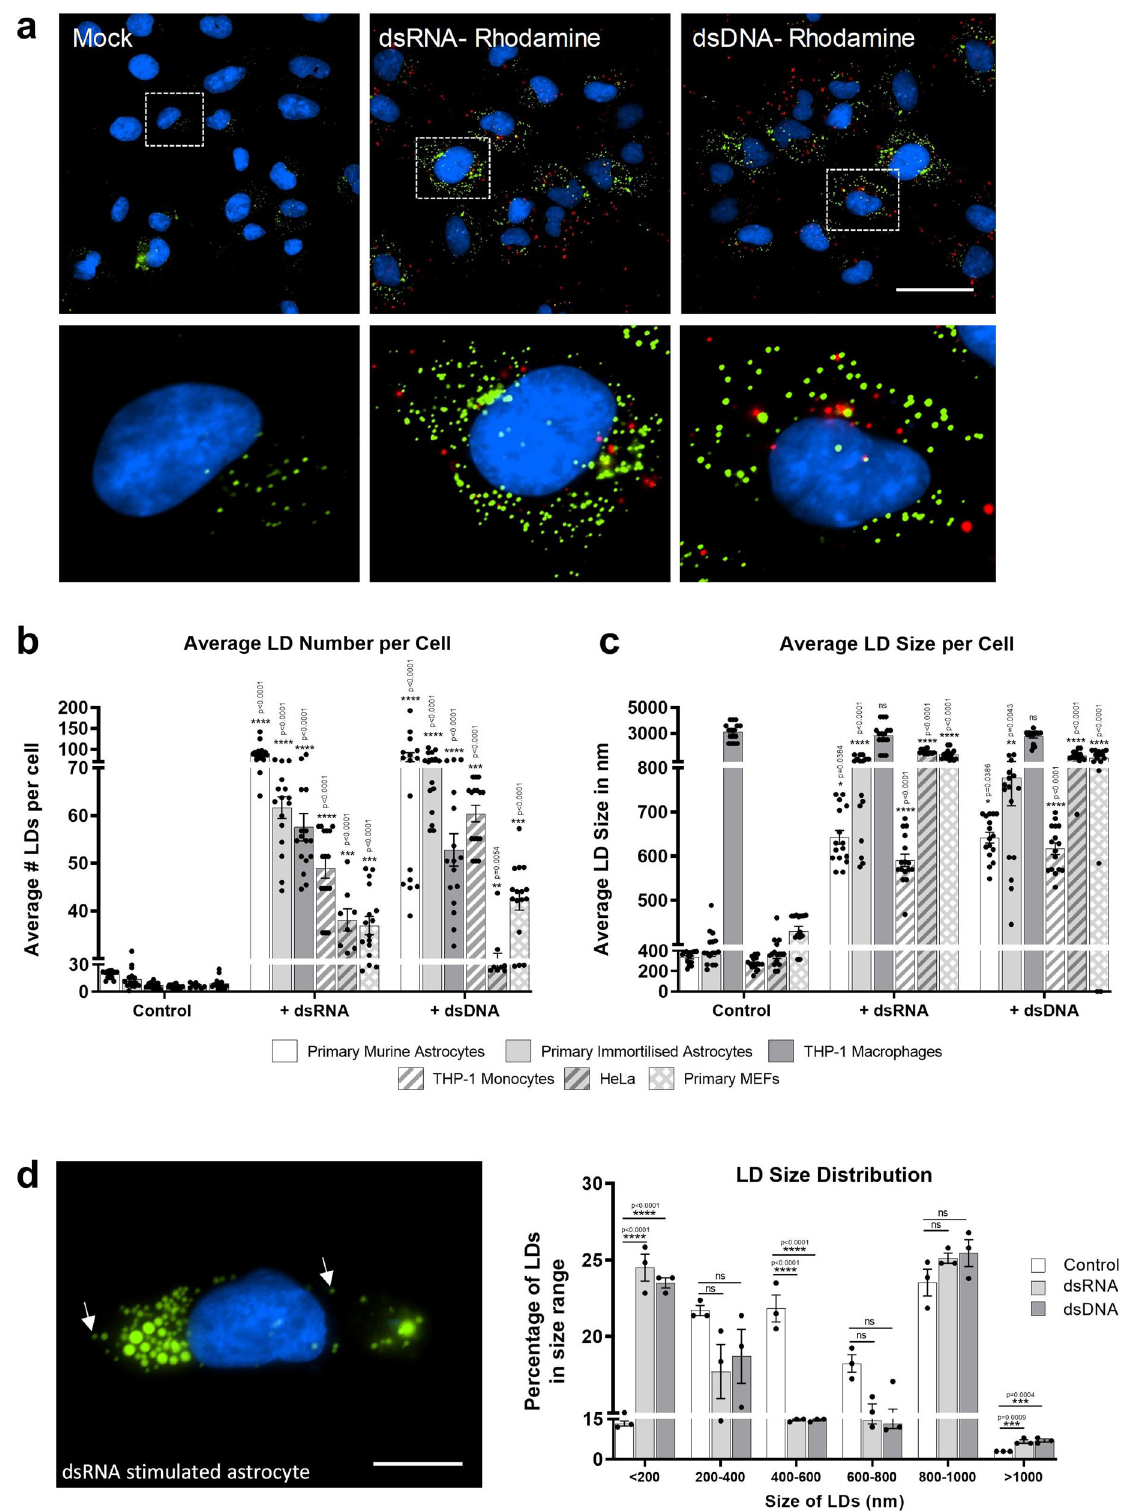
results correlated well with a reduced viral load of both ZIKV and HSV-1 at 24 h (6.3-fold and 2.3-fold for ZIKV and HSV-1 respectively) (Fig. 5d, e) and at 48 h post infection (1.4-fold decrease in ZIKV mRNA and a 2.6-fold decrease in HSV-1 (Fig. 5d, e)). This reduction in viral load for ZIKV coincided with a signi fi cantly enhanced level of both IFN- β and